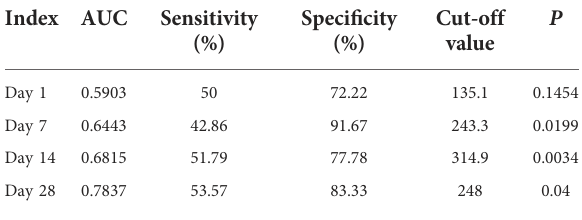
TABLE 3 Diagnostic value of IL-18 for predicting BPD at different time points.